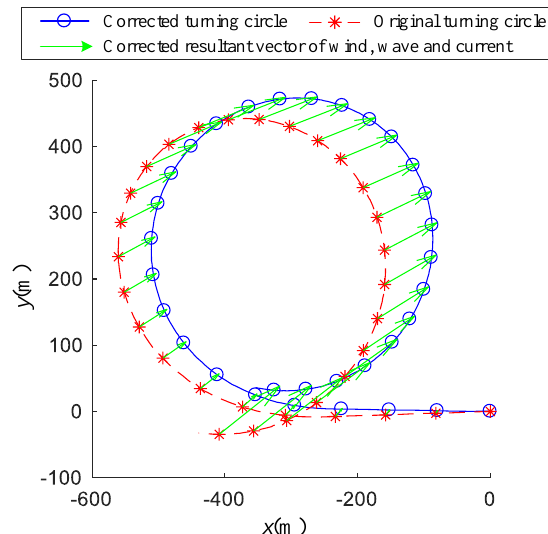
Figure 9. Correction of drift distance induced by the wind, waves and currents for + 20 ◦ turning circle test.